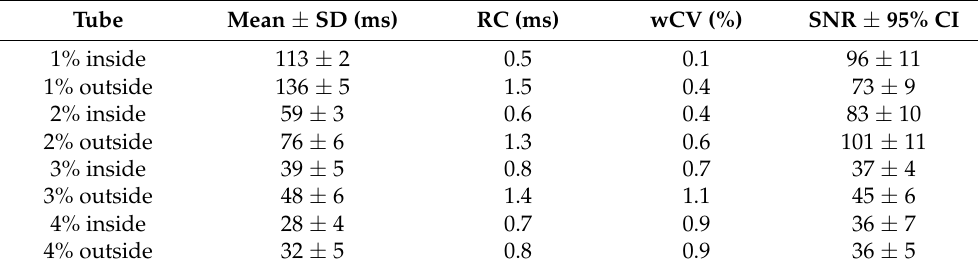
Table 2. Metrics derived from the phantom measurements: Inside indicates a tube positioned in the inner four spaces of the phantom holder and outside indicates tubes placed close to the edge of the phantom. The mean and SD were calculated from the voxels inside the ROIs in the first scan. RC = repeatability coefficient, wCV = within-tube coefficient of variation, SNR = signal-to-noise ratio.